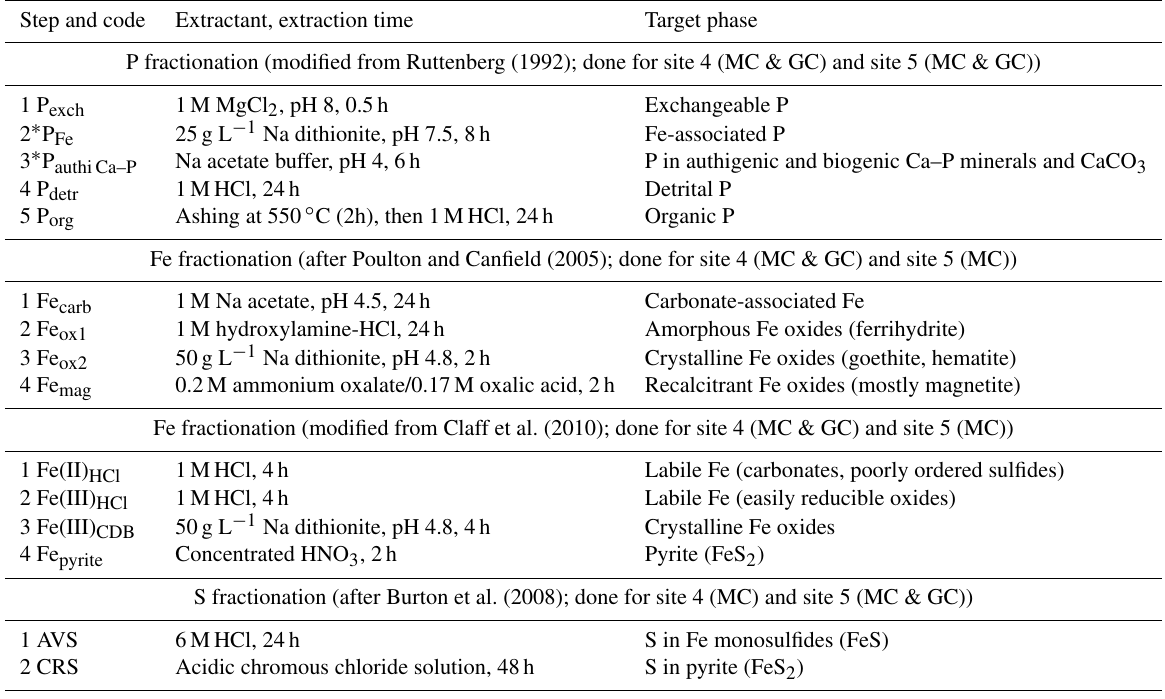
Table 1. Overview of the sequential P, Fe and S fractionation methods used in this study. Step and